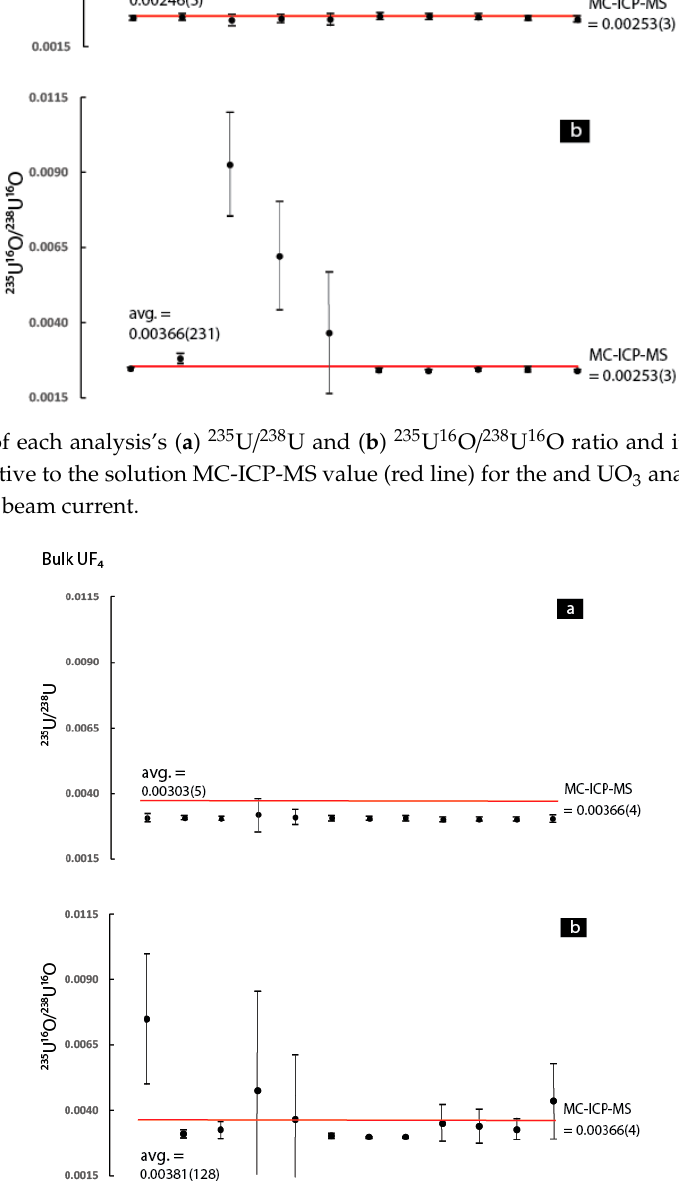
Figure 8. Plot of each analysis’s ( a ) 235 U/ 238 U and ( b ) 235 U 16 O/ 238 U 16 O ratio and its associated 1 σ uncertainty relative to the solution MC-ICP-MS value (red line), for UO 2 (NO 3 ) 2 ·6(H 2 O) analyzed using the 200 pA primary beam.